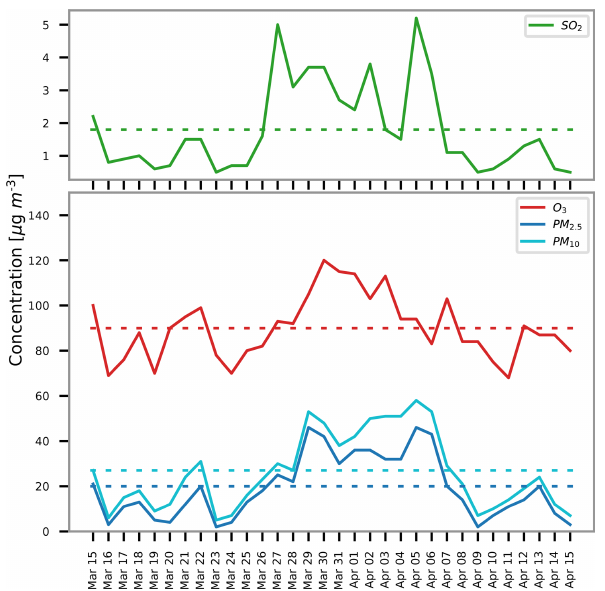
Figure 1. In situ SO 2 , O 3 , PM 2 . 5 , and PM 10 concentrations measured at Pillersdorf, Austria (EMEP station AT30, 48 ◦ 43 (cid:48) N, 15 ◦ 55 (cid:48) E). The dotted lines represent the averaged values for the plotted period.